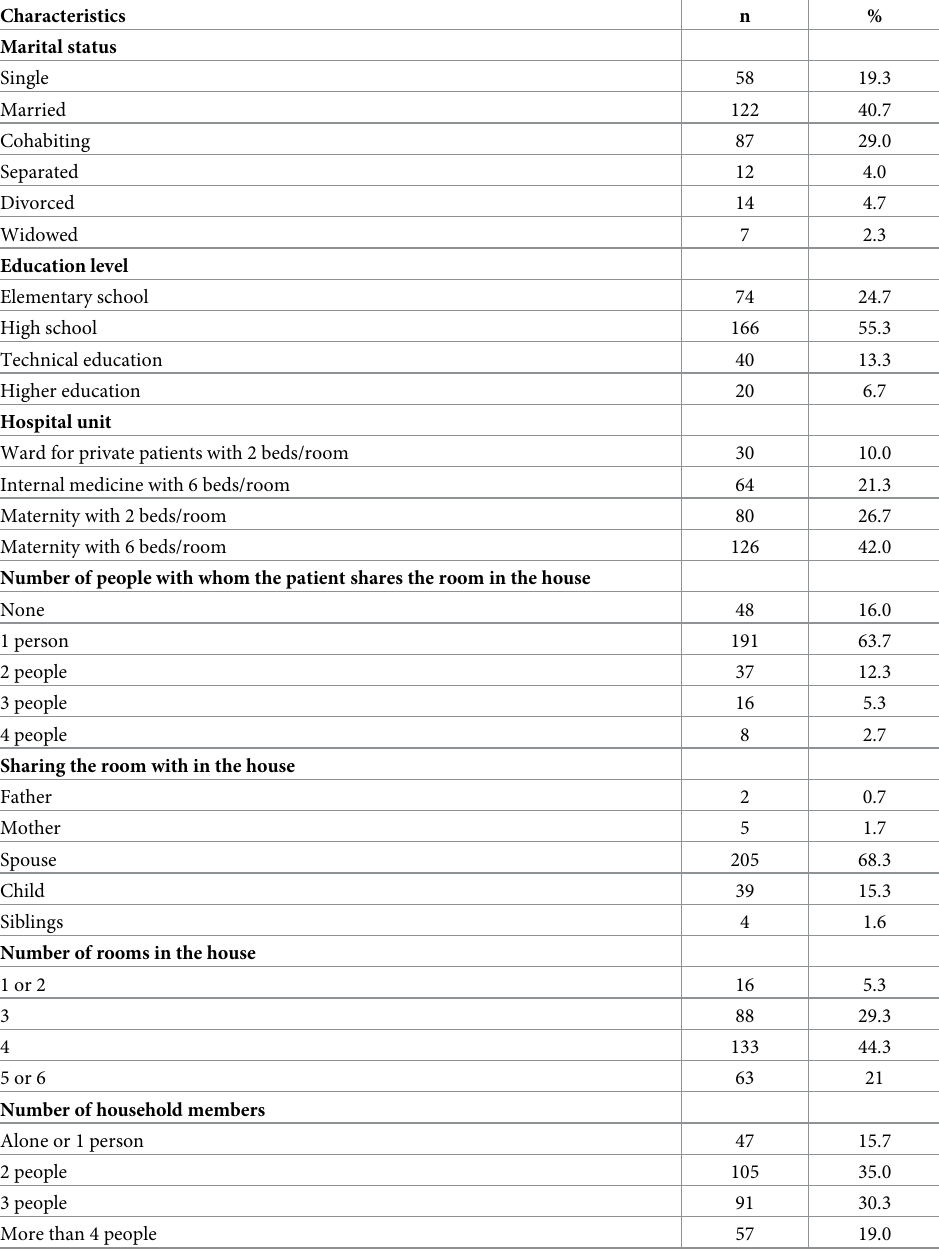
Table 1. Personal, hospital and housing characteristics of the participants.